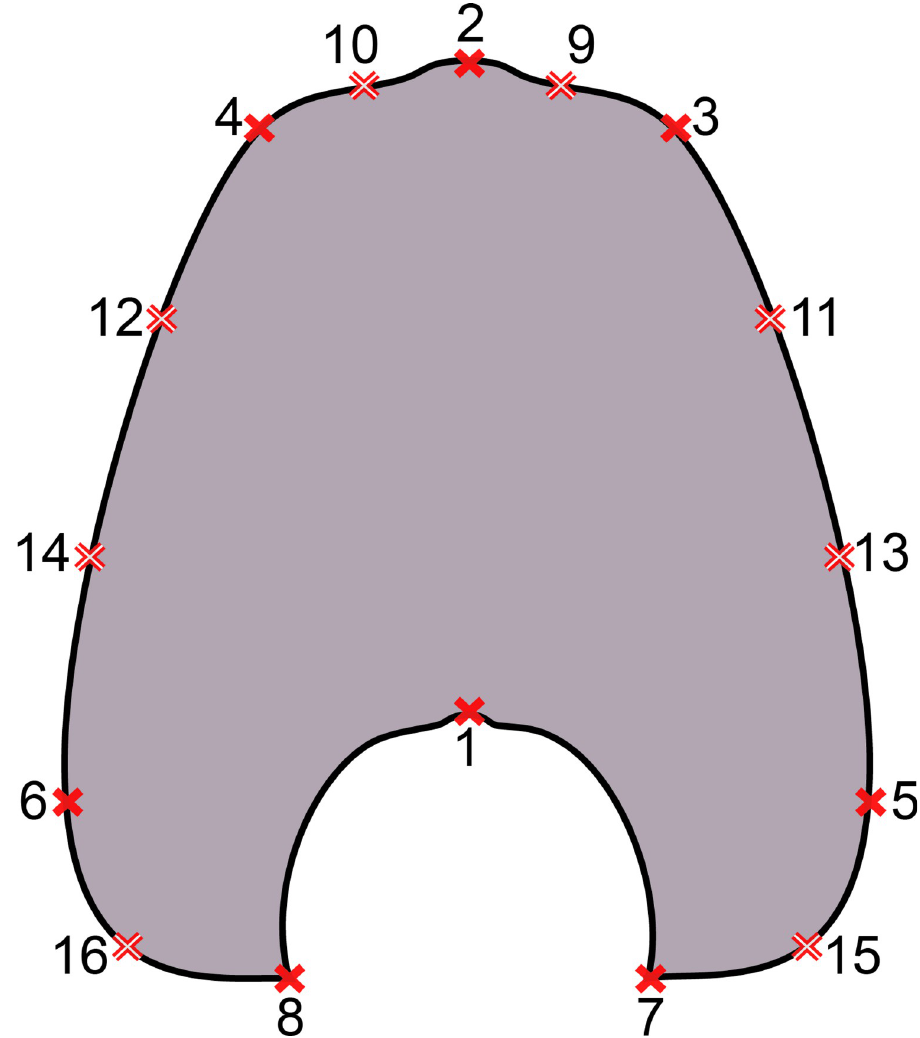
Fig 2. Digitized sketch of high-precision cross-section of an ammonoid whorl with position of landmarks. Filled crosses: fixed landmarks; empty crosses: sliding landmarks; black numbers: number of landmark. Definition of fixed landmarks: 1) venter of preceding whorl; 2) venter of whorl; 3 and 4) ventral shoulder or point of highest curvature; 5 and 6) maximum width; 7 and 8) Umbilical seam.